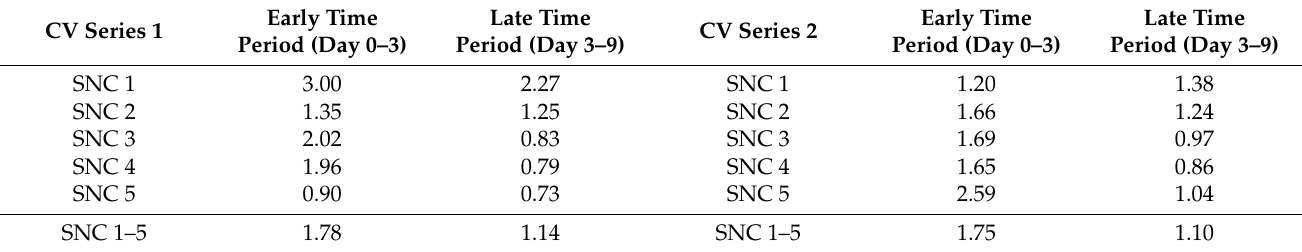
Table 2. Coefficient of variance (CV) for relative growth rates in the systematic negative control experiments of both experimental series, representing variance between randomisation groups of each experiment (CV = SD × 100/mean, based on mean values of randomisation